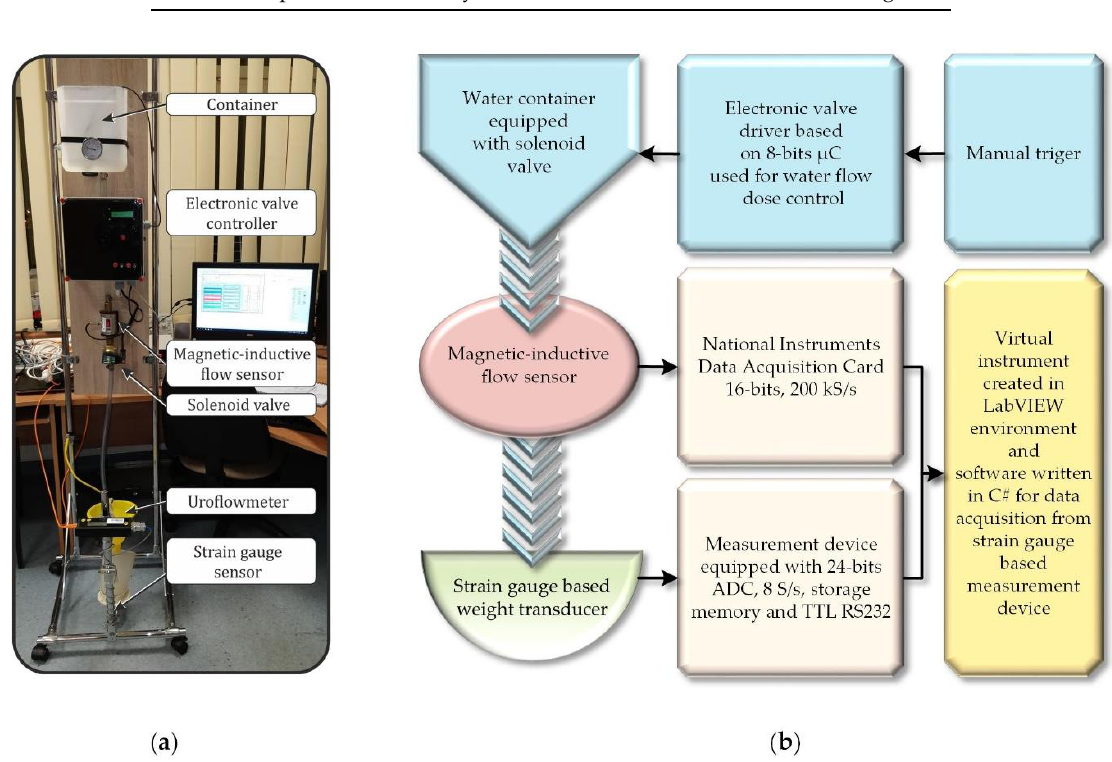
Figure 6. General view of the laboratory stand ( a ) and block diagram of the main elements used for the flow analysis of the tested uroflowmeter ( b ) [17]. flow analysis of the tested uroflowmeter ( b )